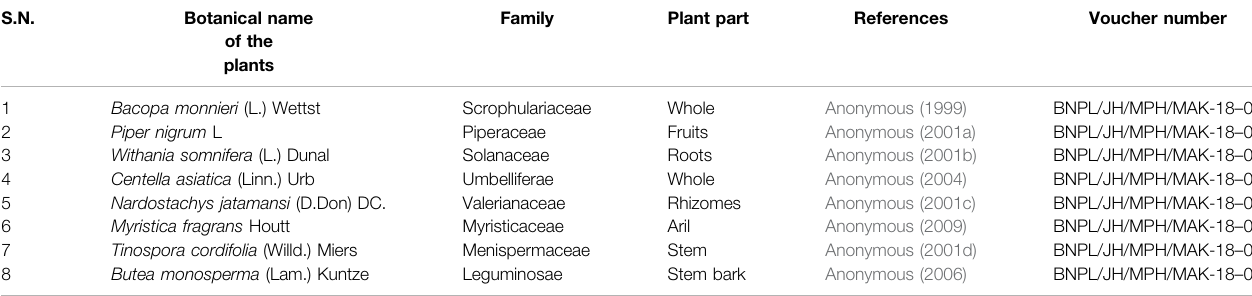
TABLE 1 | Procurement of selected plants and their voucher specimen number.